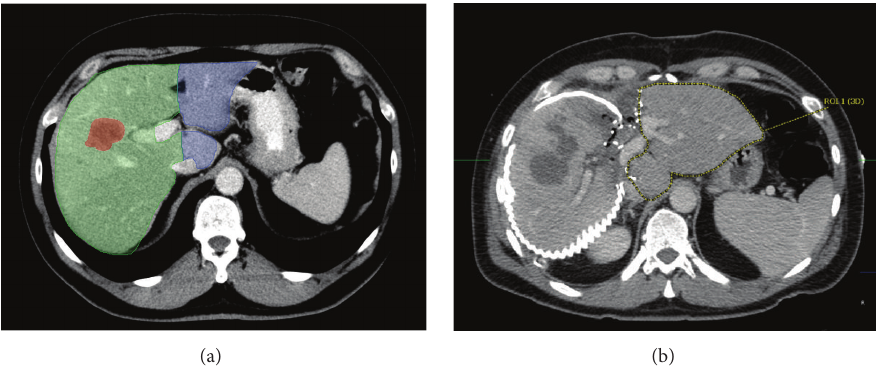
Figure 1: Pre- and postoperative CT-scan of the liver. Preoperative CT-scan depicting the tumor lesion (marked red) within the right liver lobe (a). Furthermore, the resected liver portion (marked green) and the resulting future liver remnant (FLR; marked blue) are shown. (b) CT-volumetry 10 days after the first step of ALPPS resulted in a significant increase of the FLR (marked by dotted yellow line). The extended right liver lobe (wrapped in a silicone matting) meanwhile showed signs of necrosis following ligation of the right portal